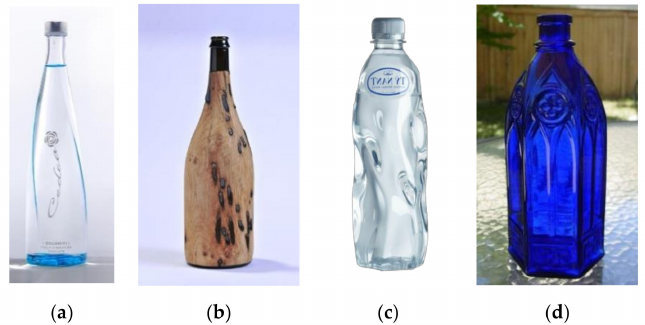
Figure 17. Di ff erent stylistic trends. ( a ) Advanced Design. ( b ) Natural Design. ( c ) Stone Design. ( d ) Retr ò Design.